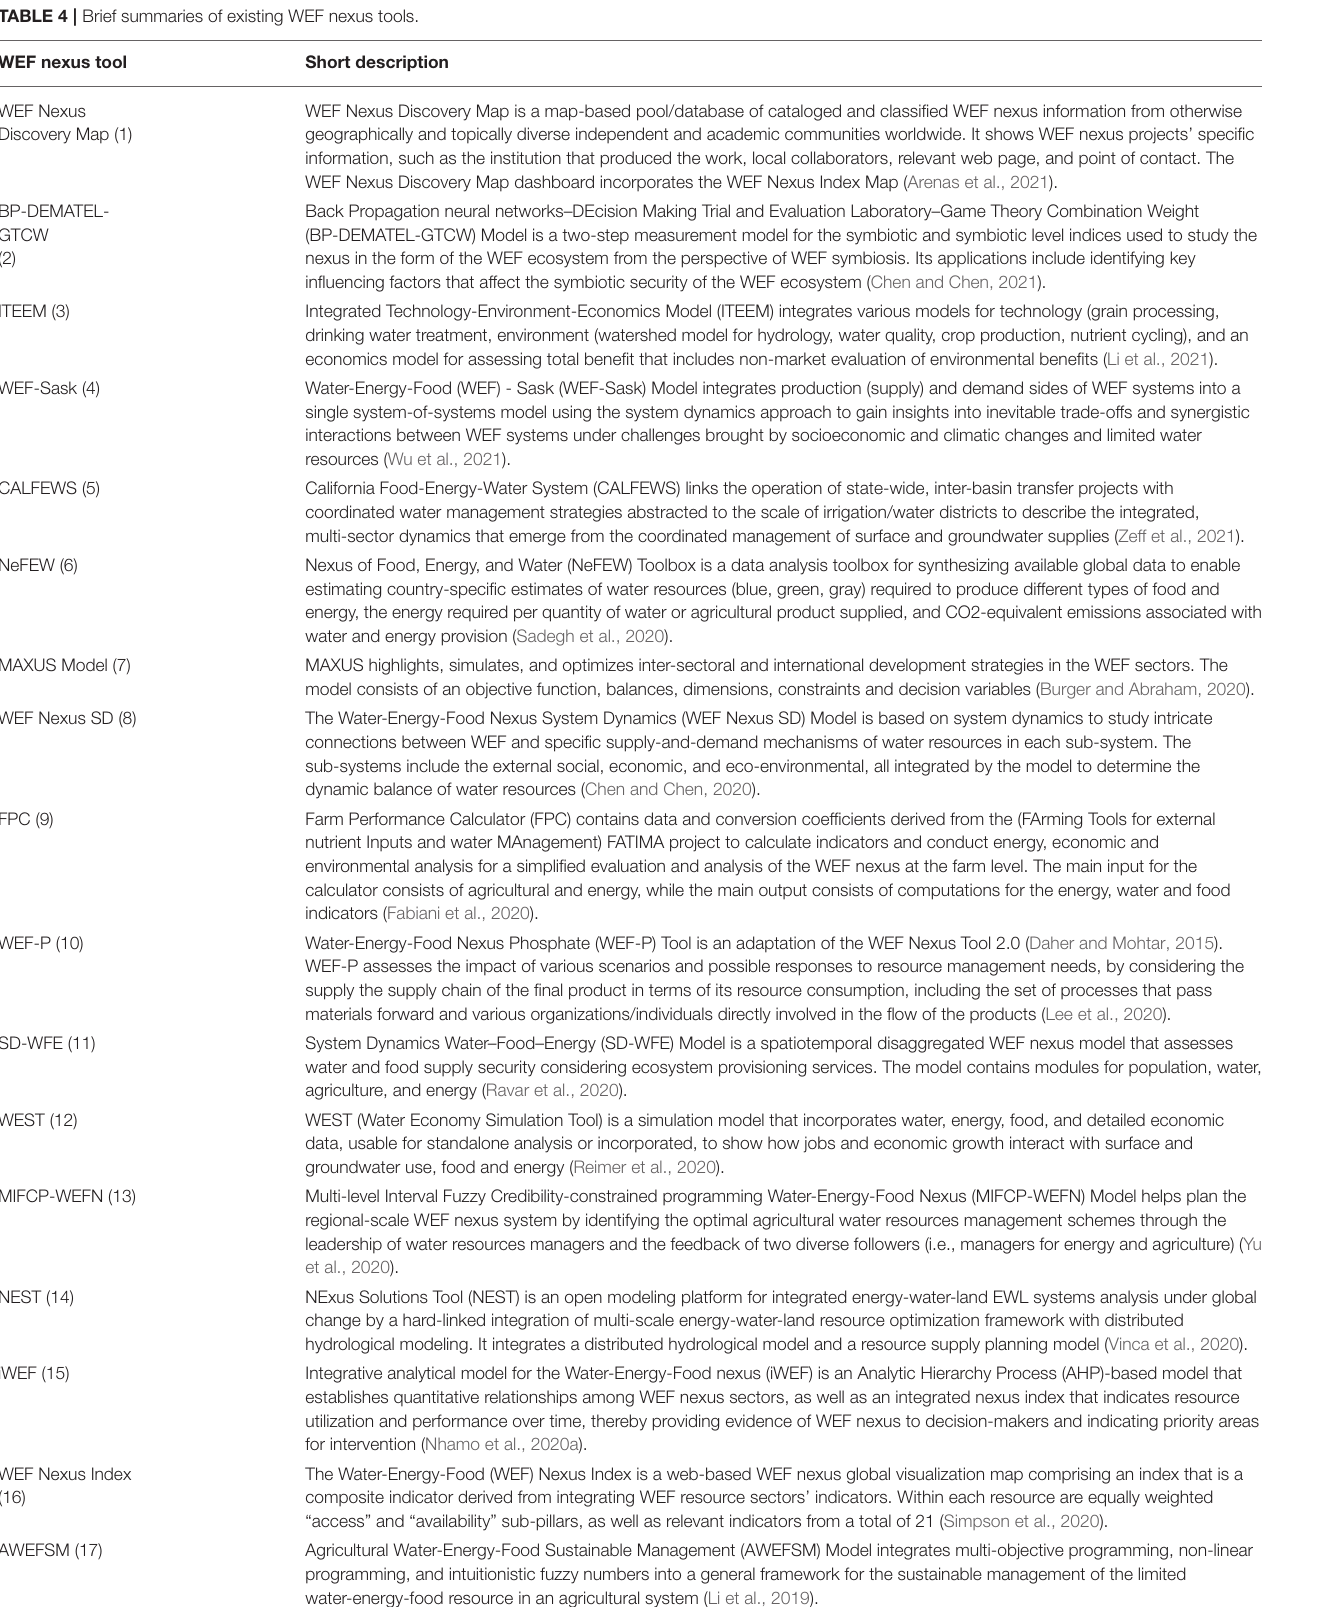
TABLE 4 | Brief summaries of existing WEF nexus